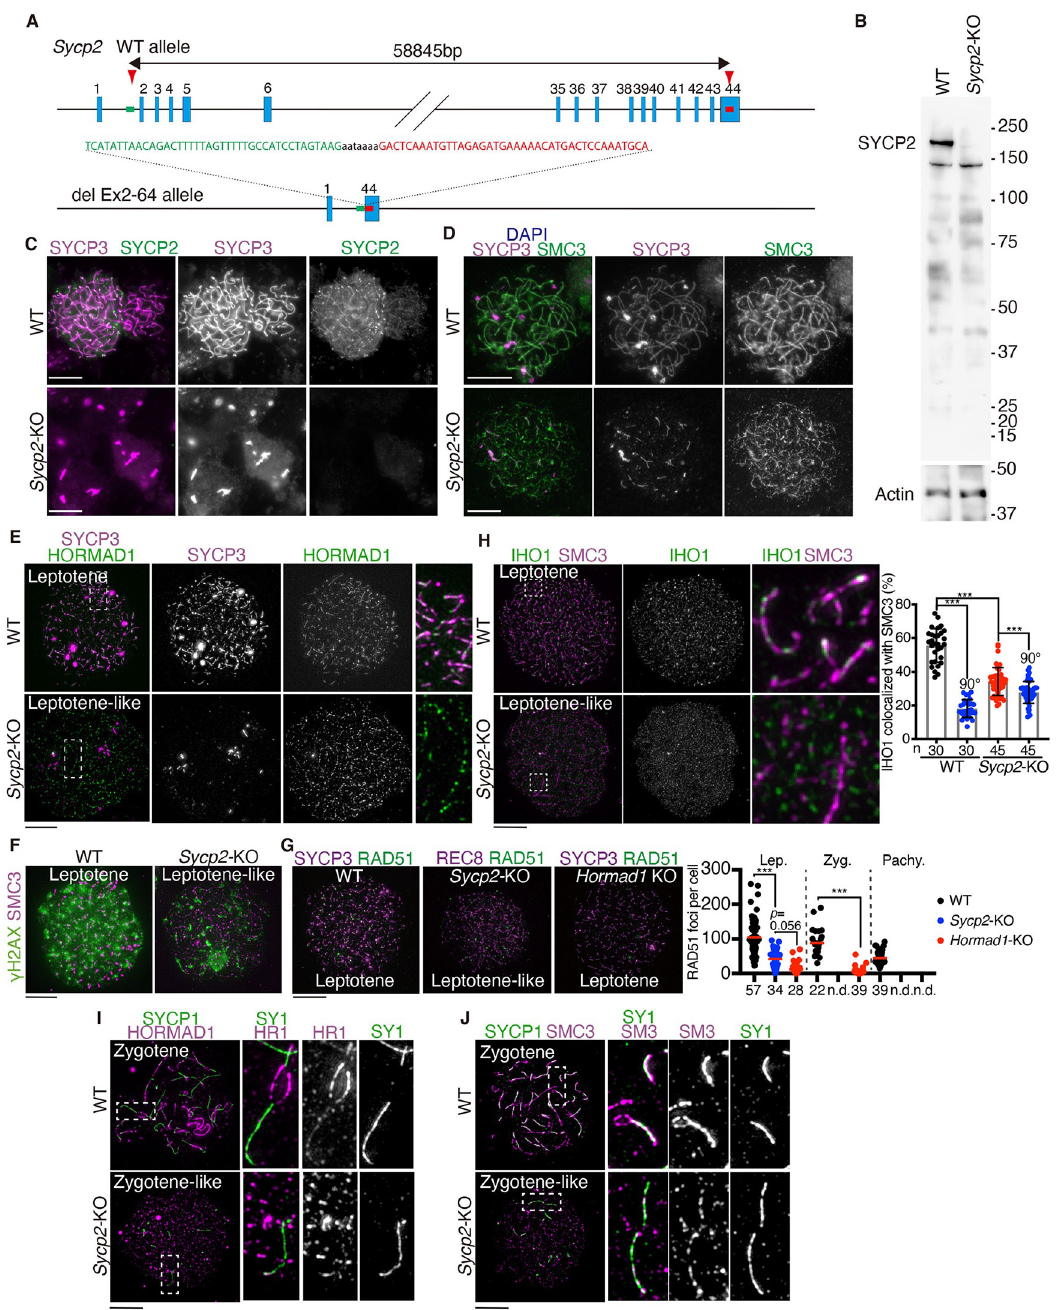
Fig 2. Generation of Sycp2 complete null mouse. (A) The targeted Exon2-Exon44 deletion allele of Sycp2 were generated by the introduction of CAS9, the synthetic gRNAs designed to target intron1 and Exon44 (arrowheads), and ssODN into C57BL/6 fertilized eggs. Two lines of KO mice were established. Line #17 of Sycp2 -KO mice were used in most of the experiments, unless otherwise stated. (B) WB analysis of testis extracts prepared from WT and Sycp2 -KO mice (P18). See also supplementary S1A Fig for immunoblots of other axis-associated proteins. (C) Chromosome spreads of WT and Sycp2- KO spermatocytes were stained for SYCP2 and SYCP3. Note that Sycp2 -KO spermatocytes showed aggregation or short stretches of SYCP3. (D) Chromosome spreads of WT and Sycp2- KO spermatocytes were stained for SMC3 and SYCP3. Note that Sycp2 -KO spermatocytes showed elongated stretches of SMC3, suggesting that cohesin axial core was generated in Sycp2- KO. (E) Chromosome spreads of WT and Sycp2- KO spermatocytes were stained for HORMAD1 and SYCP3. Enlarged images are shown on the most right. (F) Chromosome spreads of WT and Sycp2- KO spermatocytes were stained for SMC3 and γ H2AX. (G) Chromosome spreads of WT, Sycp2- KO and Hormad1 - KO spermatocytes were immunostained as indicated. Stage of Sycp2- KO spermatocytes was determined by REC8. The images